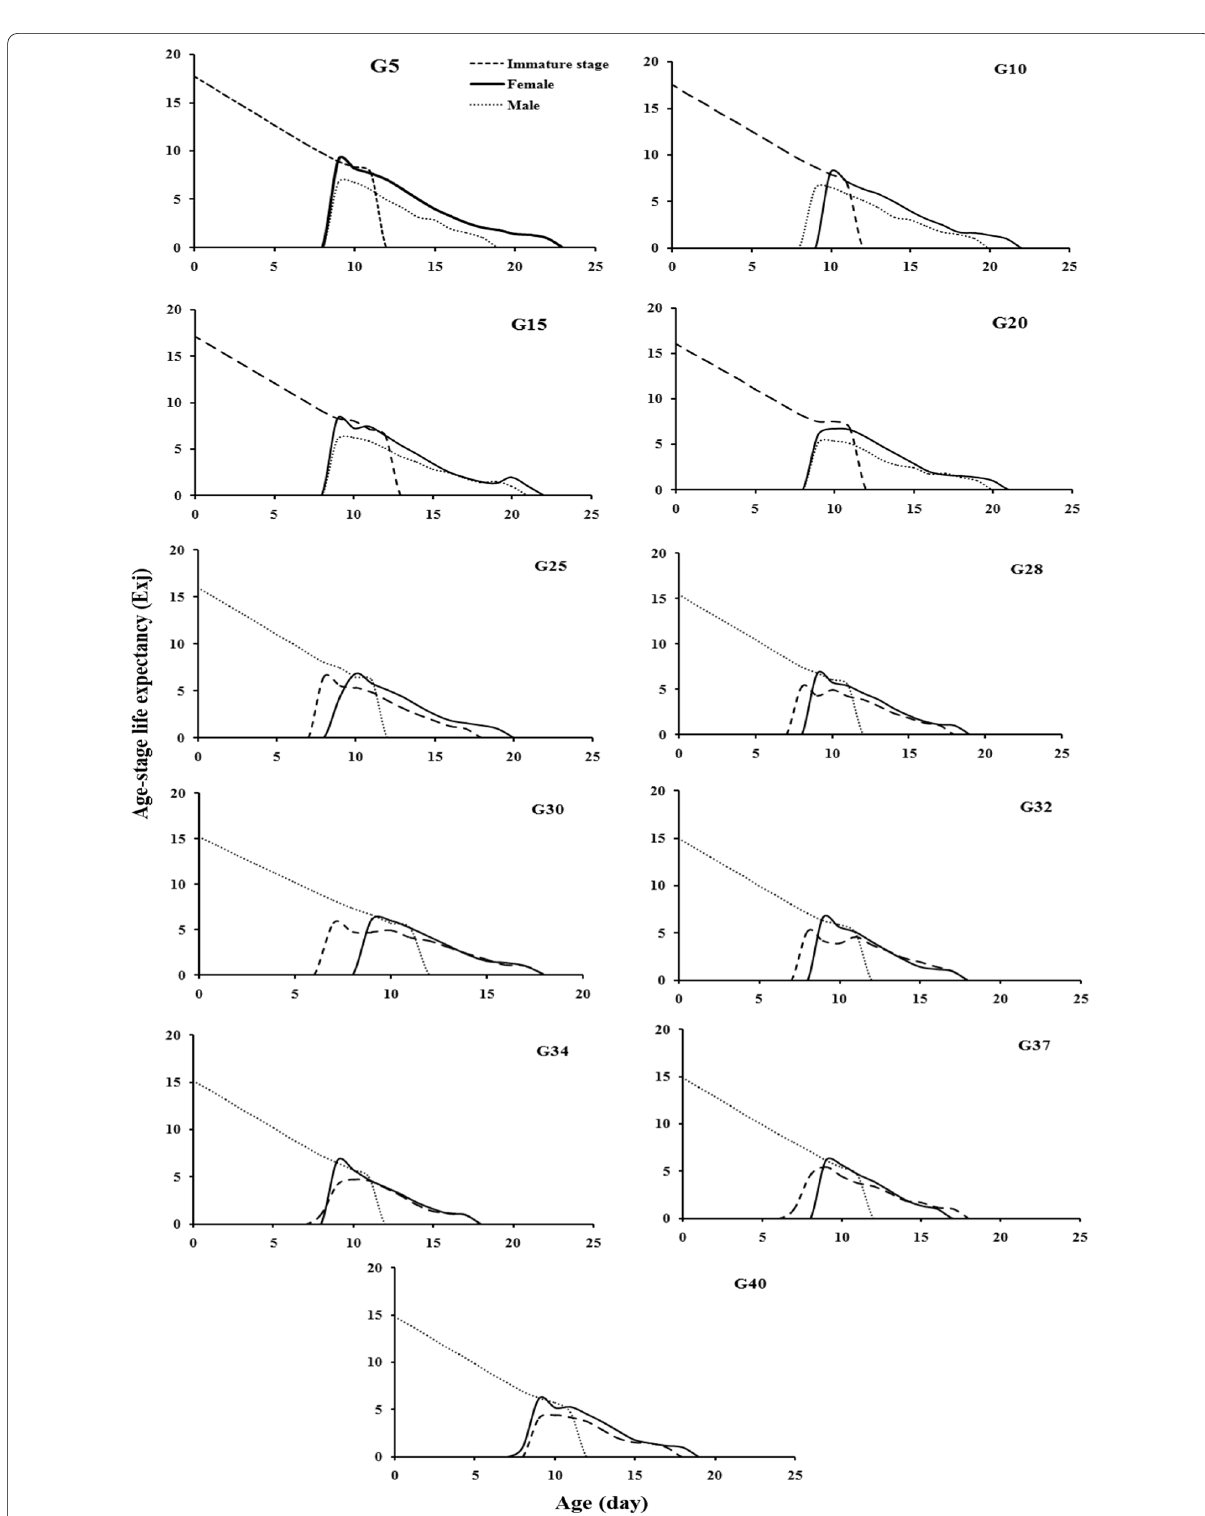
Fig. 2 The age-stage-life expectancy ( E xj ) of sequential generations (G) of T. embryophagum reared on S. cerealella